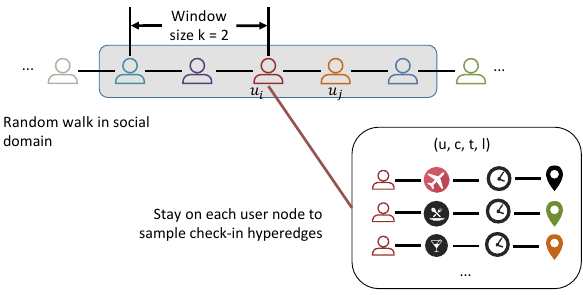
Figure 5. Random walk with stay on the LBSN hypergraph [52].